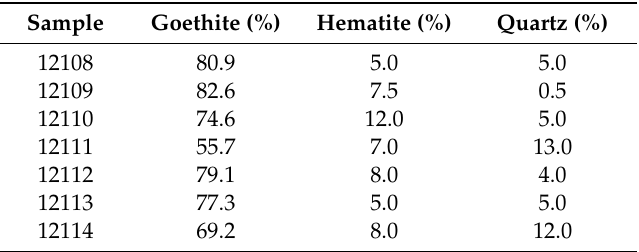
Table 1. Calculated goethite, hematite, and quartz content from mineral phases.